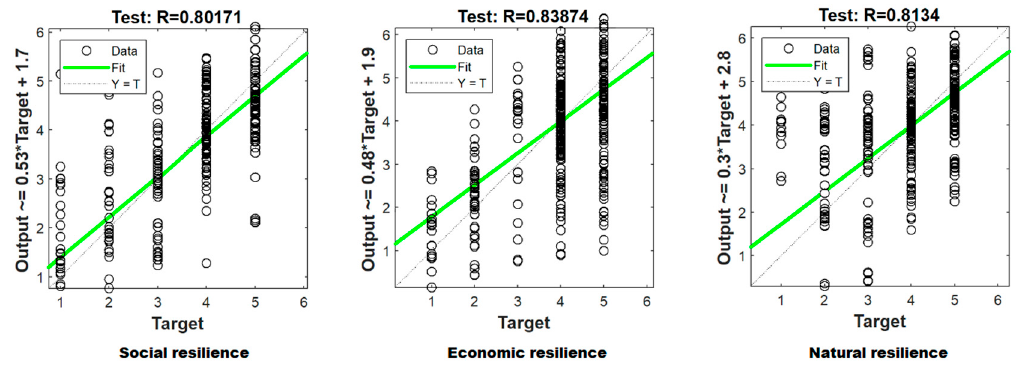
Figure 9. Test sample output value and expected value goodness of fit.